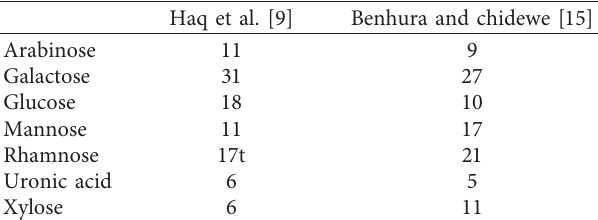
Table 2: Ratio of sugar composition in gum